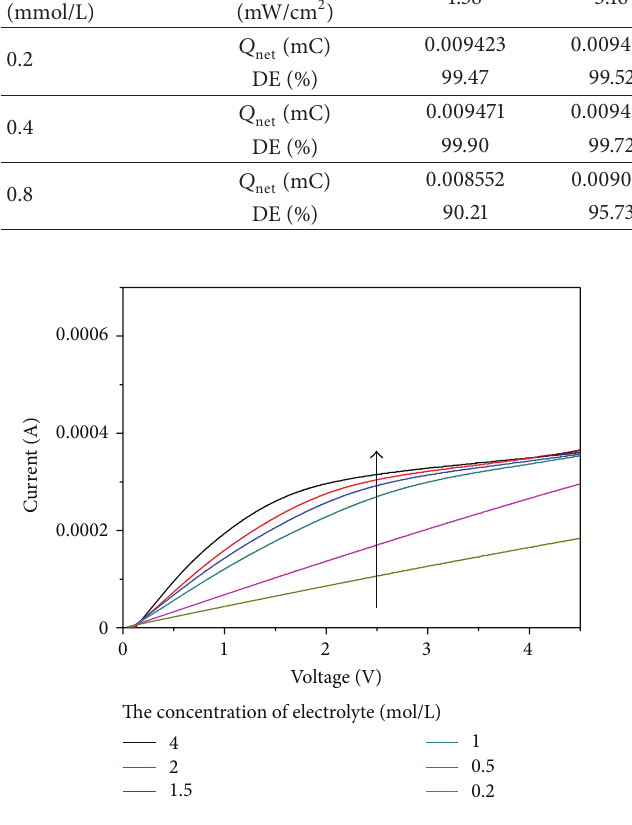
Table 2: 𝑄 value and degradation efficiency (DE) of different concentrations of benzoic acid under varying light intensities. net Concentration